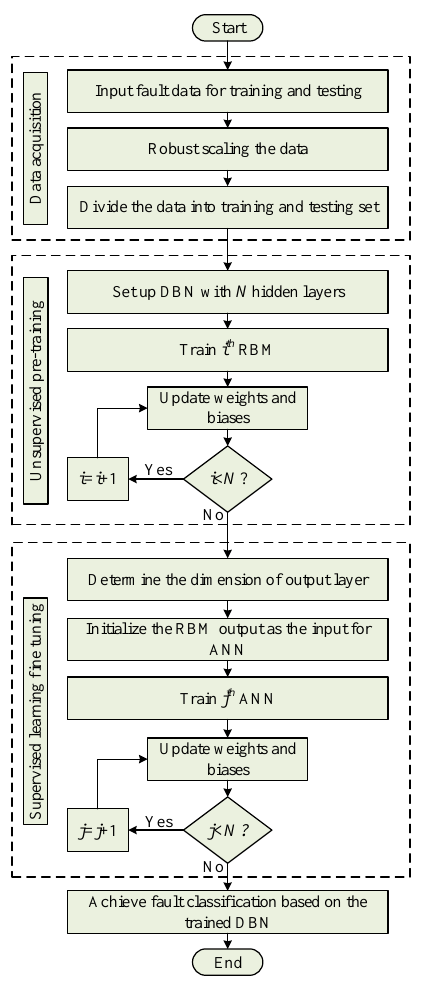
Figure 10. Flowchart of the DBN based fault classification